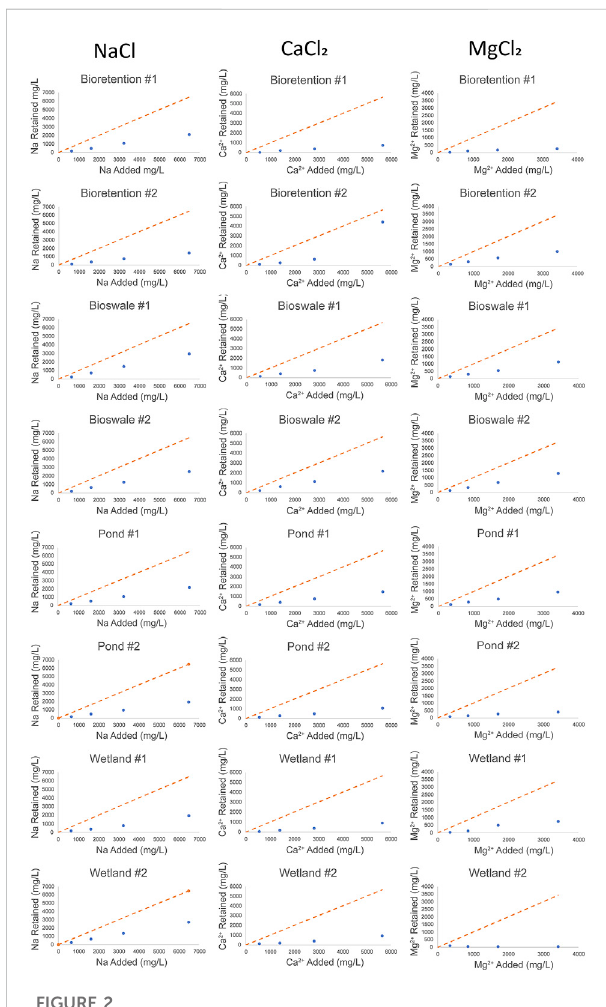
FIGURE 2 Na, Ca 2+ , and Mg 2+ retention after NaCl, CaCl 2 , and MgCl 2 incubations. The orange dash line indicates 100% adsorption, and the blue circles are the measured values in